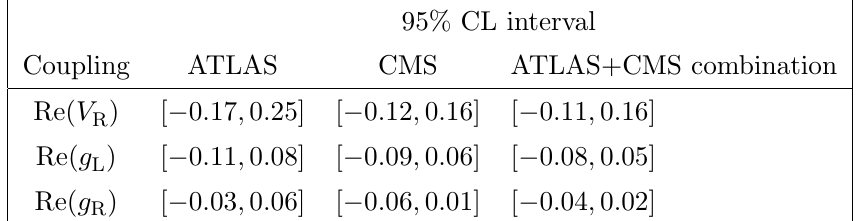
Table 8 . Allowed ranges for the anomalous couplings V coupling is obtained while (cid:12)xing all other couplings to their SM value. The limits from CMS are obtained using the pre-combined result of all CMS input measurements. The anomalous couplings are assumed to be